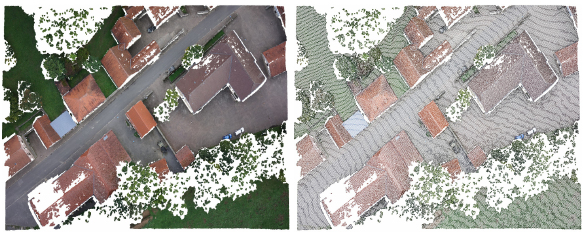
Figure 4. The left images shows the dense point cloud from